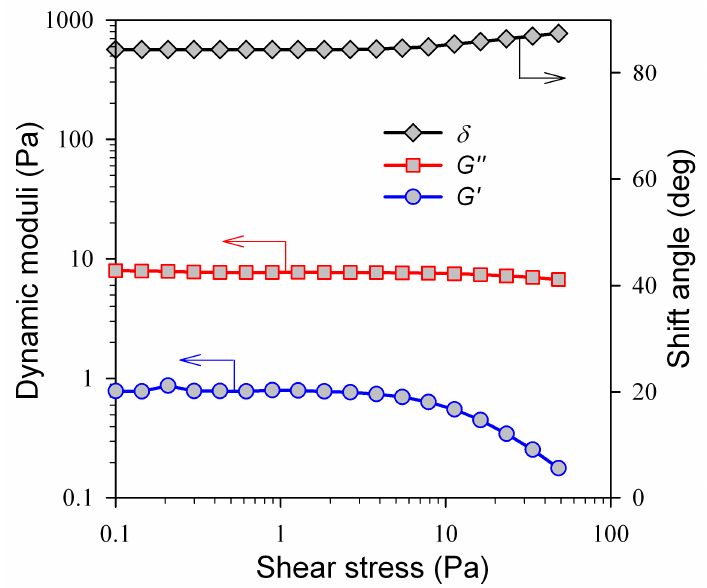
Figure 4. Shear stress dependence of the storage modulus ( G ′ ), the loss modulus ( G ″ ), and the shift angle ( δ ) for the magneto-rheological suspension of 2.8% Fe 3 O 4 MPs dispersed in 5% Na-alginate solution. Frequency of shear oscillations 1 Hz, temperature 25 °C.